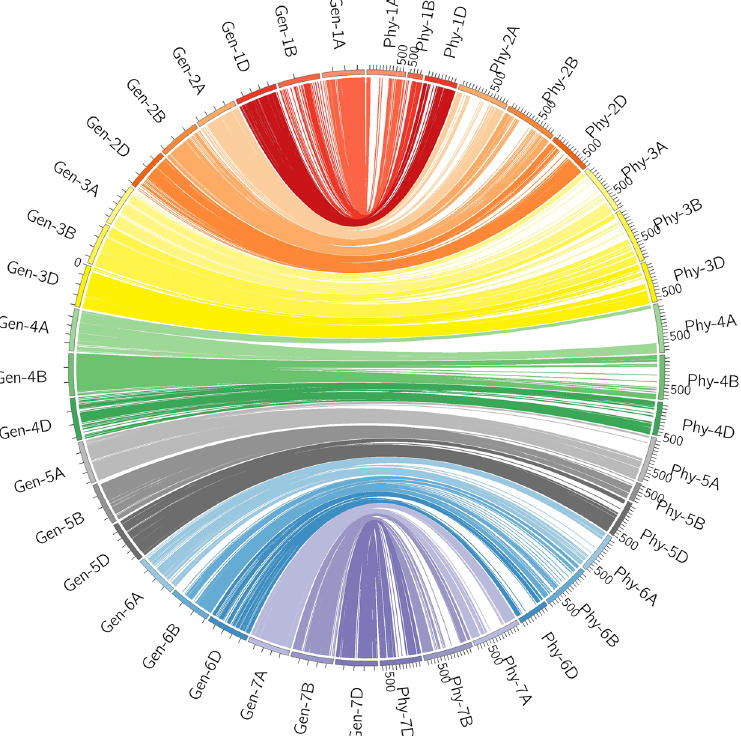
Figure 3. Schematic representation of the syntenic relationships between any one marker in wheat genetic and physical maps. Gen-1A to Gen-7D represent the 21 wheat chromosomal genetic maps released in this paper; Phy-1A to Phy-7D represent the 21 wheat chromosomal physical maps, which were constructed by assigning 116 261 SNPs to the wheat genome assembly using SNP flanking sequences as the query. For the redundant loci that showed co-segregation in the 188 KJ-RILs, only one unique informative marker is shown in this figure.